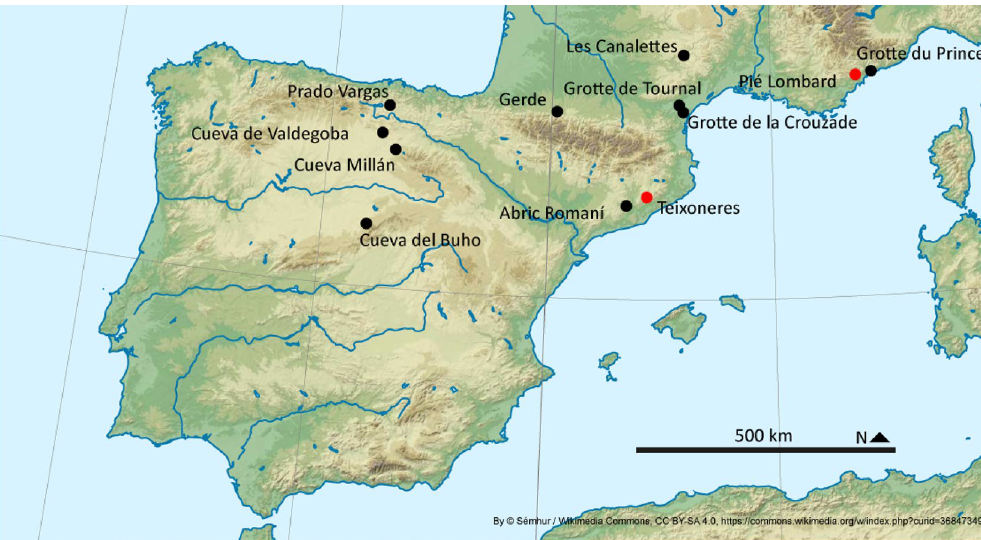
Figure 1. Geographical position of Pié Lombard rockshelter and Teixoneres cave (in red) and of MIS 5 to 3 Cervus and Capreolus populations used as examples in this work (in black). Map base by Sémhur / Wikimedia Commons, CC BY-SA 4.0, https:// commo ns. wikim edia. org/w/ index. php? curid= 36847